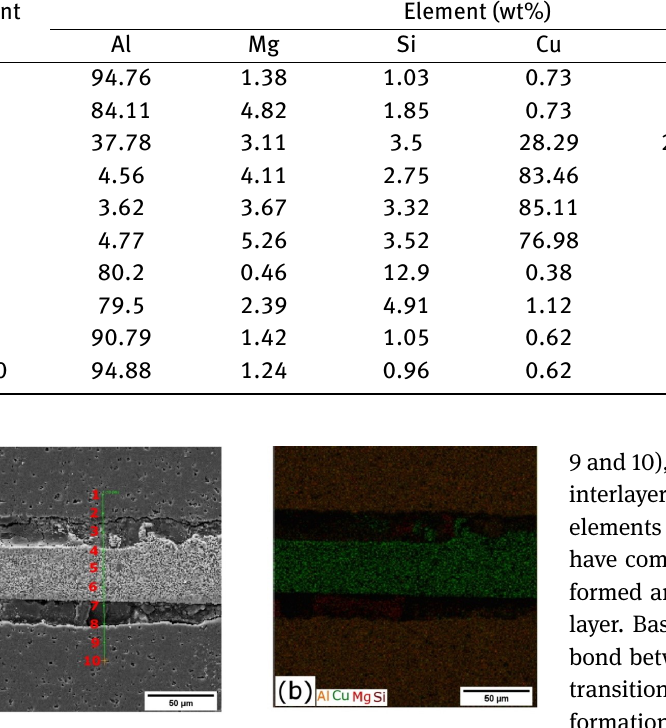
Figure 7: Microstructure in the interface of W15 P-FSSW joints (a) SEM image and (b) EDX